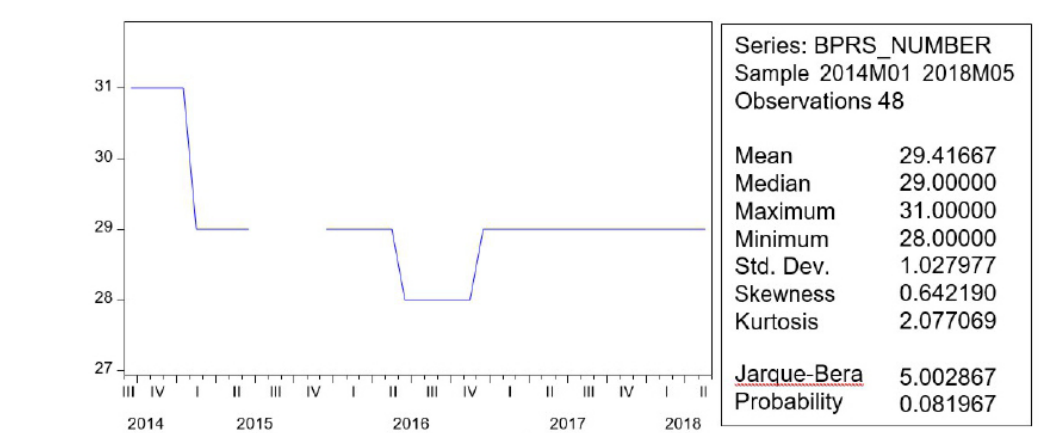
Figure 1: BPRS Numbers in East Java Province Source: Data Processed